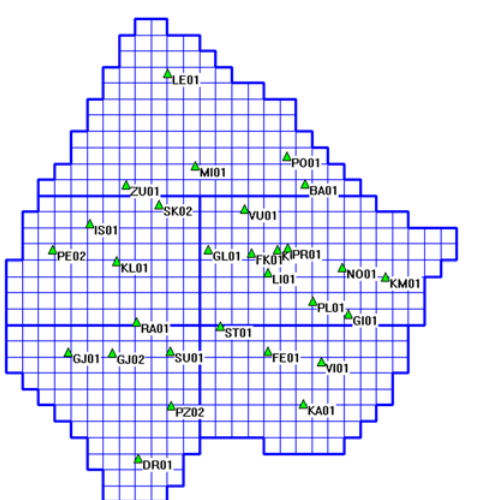
Fig. 2. Definition of patches and mashes for the selected area of